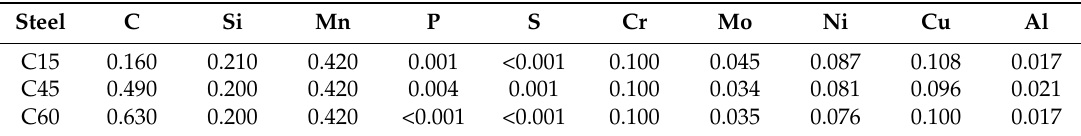
Table 1. Real chemical composition as weight fraction of the test melts via optical emission spectrometry (rest: